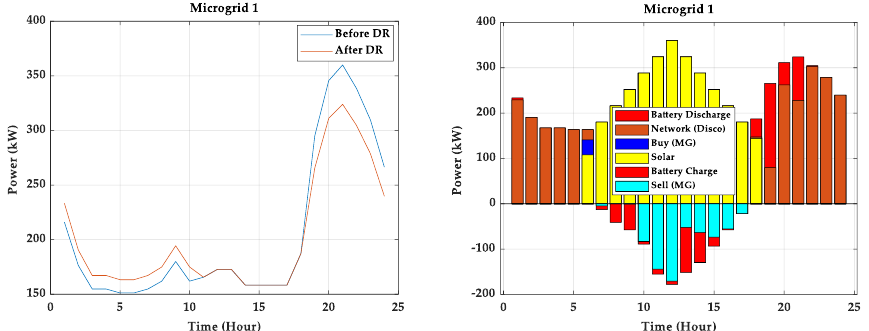
Figure 22. Impact of demand response on MG 1.